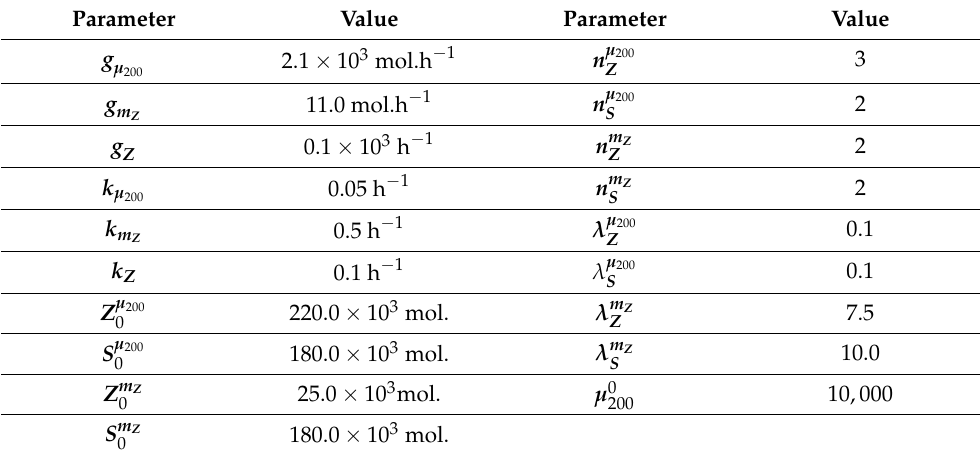
Table 1. Kinetic parameters for the EMT circuit ODE model.